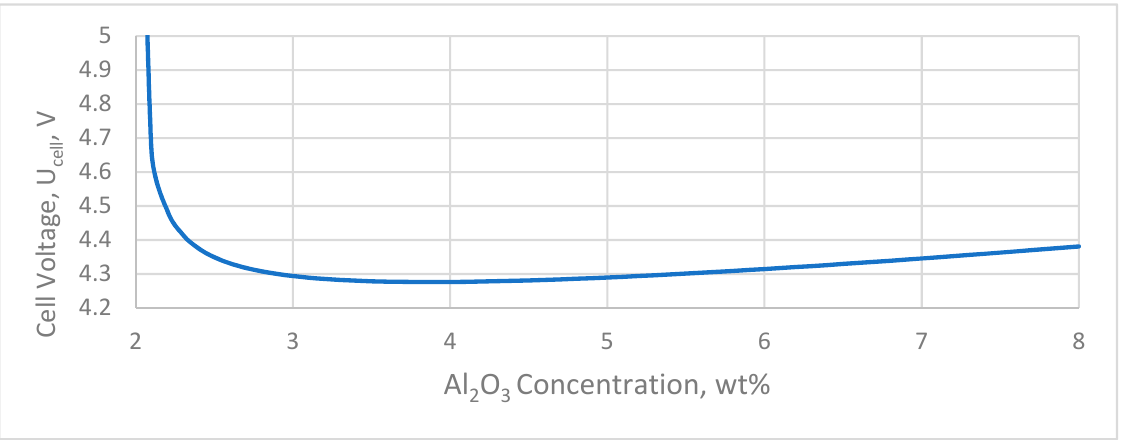
Figure 8. Overall voltage drop towards Al 2 O 3 concentration on bath.